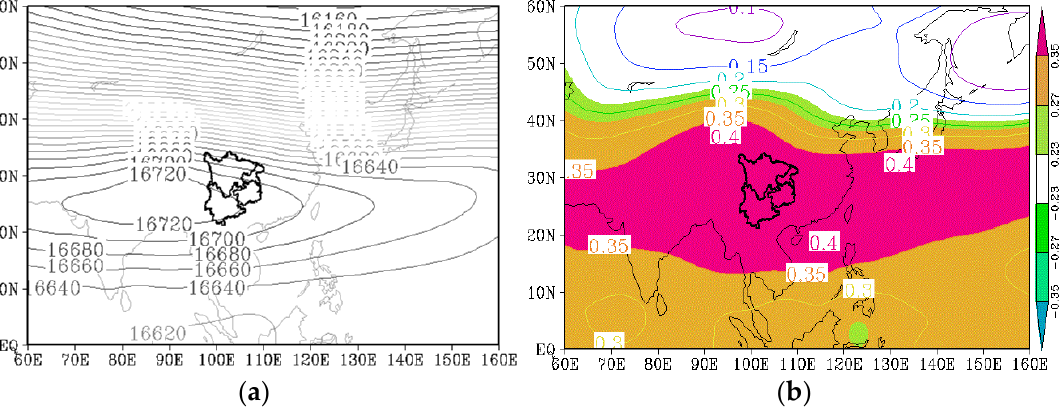
Figure 10. The 100 hPa height field of rainstorms and floods in high-value years ( a ), the correlation coefficient ( b ) of rainstorms and floods, and 100 hPa height field in the summer half-year during 1961 – 2021. The shaded areas represent those where the correlation passes 90% (Green), 95% (Brown), and 99% (Rose) significance levels.